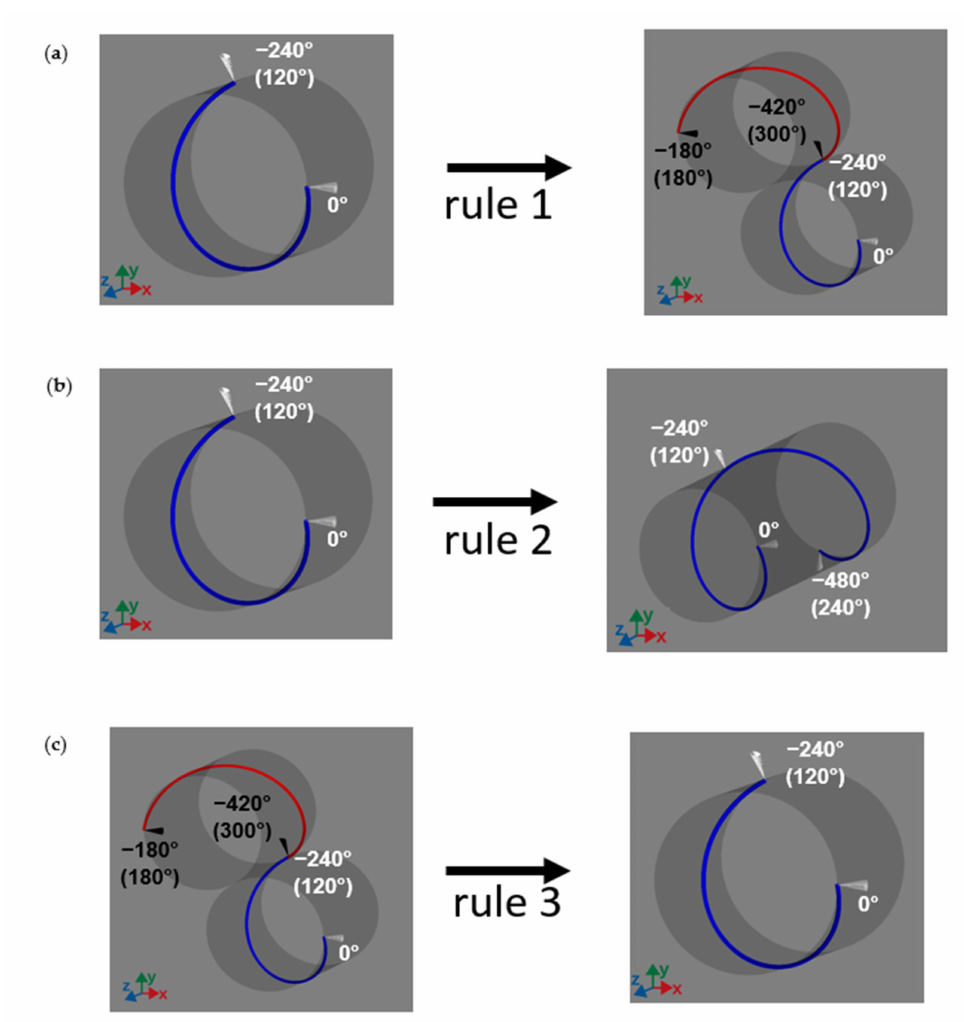
Figure 3. Shape grammar example for scaffold routing when constrained to a honeycomb lattice architecture. The scaffold is sectioned into 7-base helical segments with the physical dimension of the dsDNA right-handed double helix. The blue helix segment is directed in the − z direction (5 (cid:48) end to 3 (cid:48) end) while the red helix segment is directed in the + z direction (3 (cid:48) end to 5 (cid:48) end): ( a ) Rule 1 is for generating helix segments that crossover to a neighboring helix (0 ◦ , 120 ◦ , and 240 ◦ for the blue helix, in order; − 180 ◦ , 60 ◦ , and 300 ◦ for the red helix, in order). Illustrated is a crossover at 120 ◦ from the blue helix segment; ( b ) Rule 2 is for extending the helix by a segment. Illustrated is an extension at 120 ◦ from the blue helix segment to create a longer helix ending at 240 ◦ ; ( c ) Rule 3 is for removing a 7-base helical segment to prevent rapid convergence on an inferior solution. Illustrated is an example of rule 3, which here is the reversal of rule 1 by removing the red helix segment at 300 ◦ which leaves the blue helix segment ending at 240 ◦